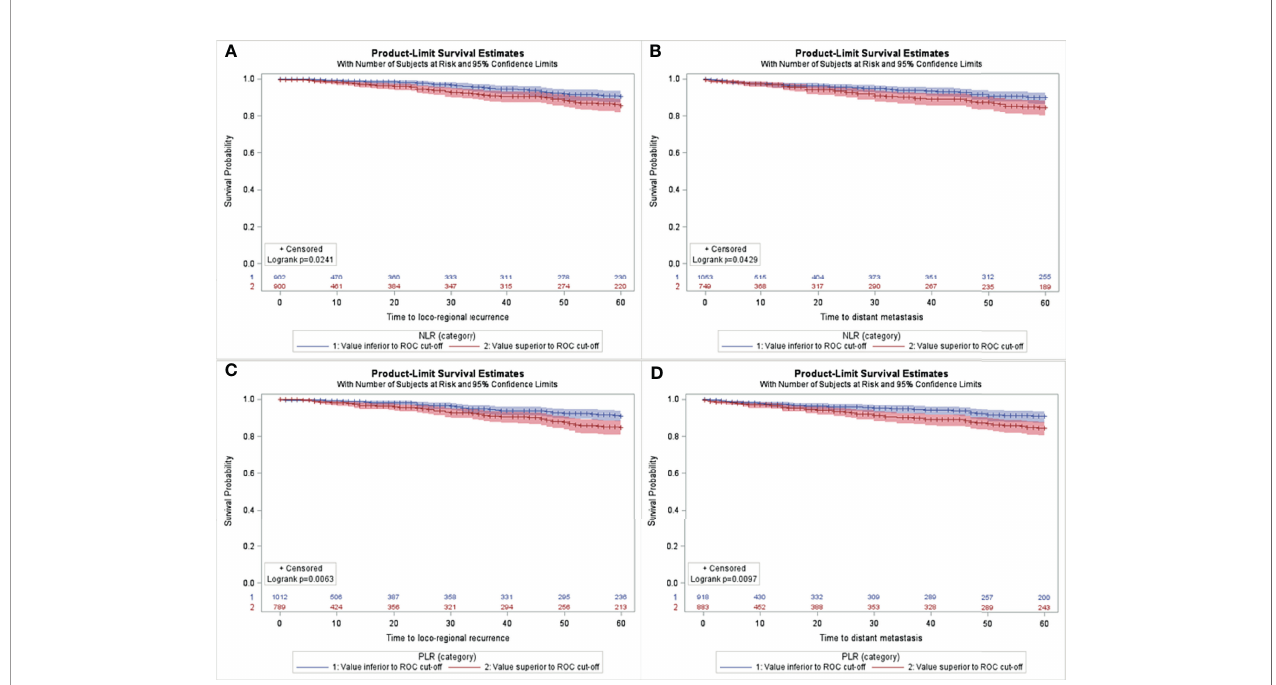
FIGURE 1 | Kaplan-Meier curves for LRRFS (A, C) and DMFS (B, D) according to low vs. high NLR (A, B) or PLR (C, D) in the study population (n=1806).